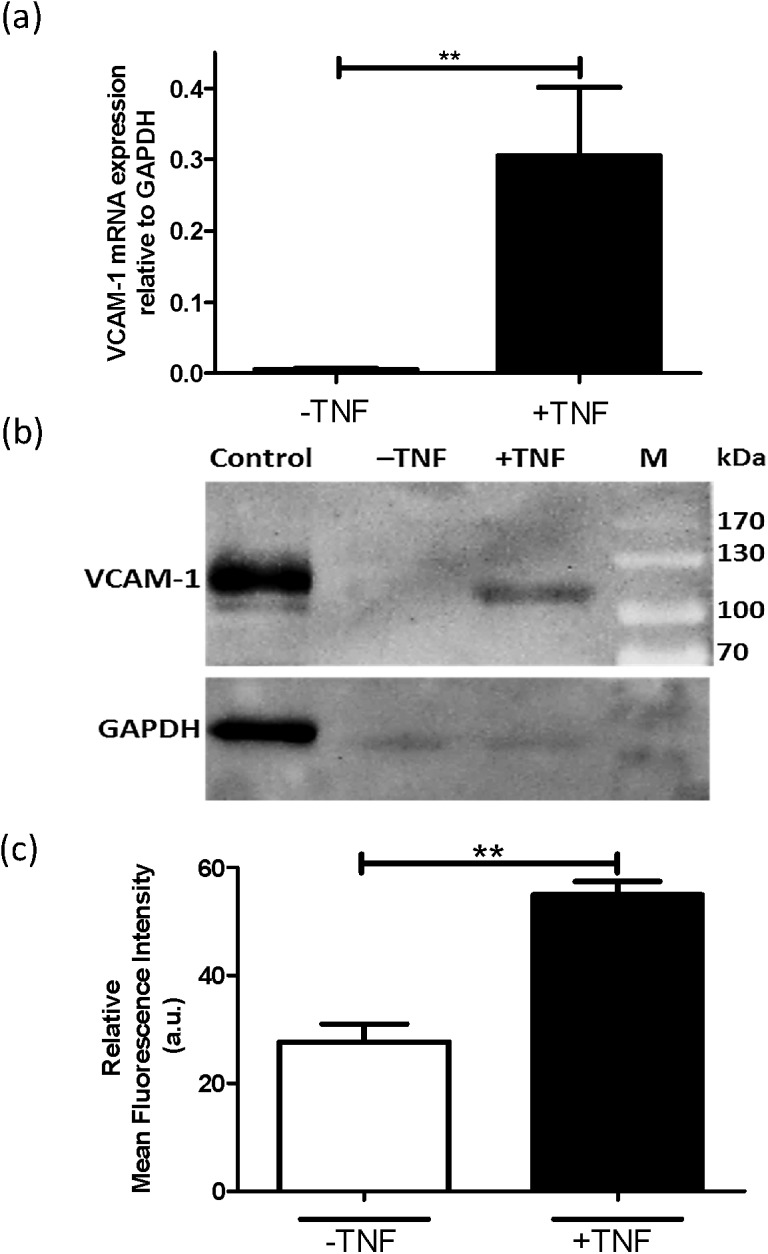
VCAM-1 is expressed by the mouse podocyte cell line MPC-5.(a) mRNA expression of VCAM-1 in the absence (-) or presence (+) of TNFα (10 ng/ml; 24 h) as analyzed by RT-qPCR analysis. (b) Western blot analysis of protein extracts of MPC-5 cells that were incubated in the absence (-) or presence (+) of TNFα (10 ng/ml; 24 h) prior to harvesting. M and control indicate respectively, pre-stained molecular weight marker and positive control (HUVEC activated with LPS for 6 h). (c) FACS analysis of VCAM-1 expression by MPC-5 cells using anti-VCAM-1 antibody by flow cytometry. *p <0.001.